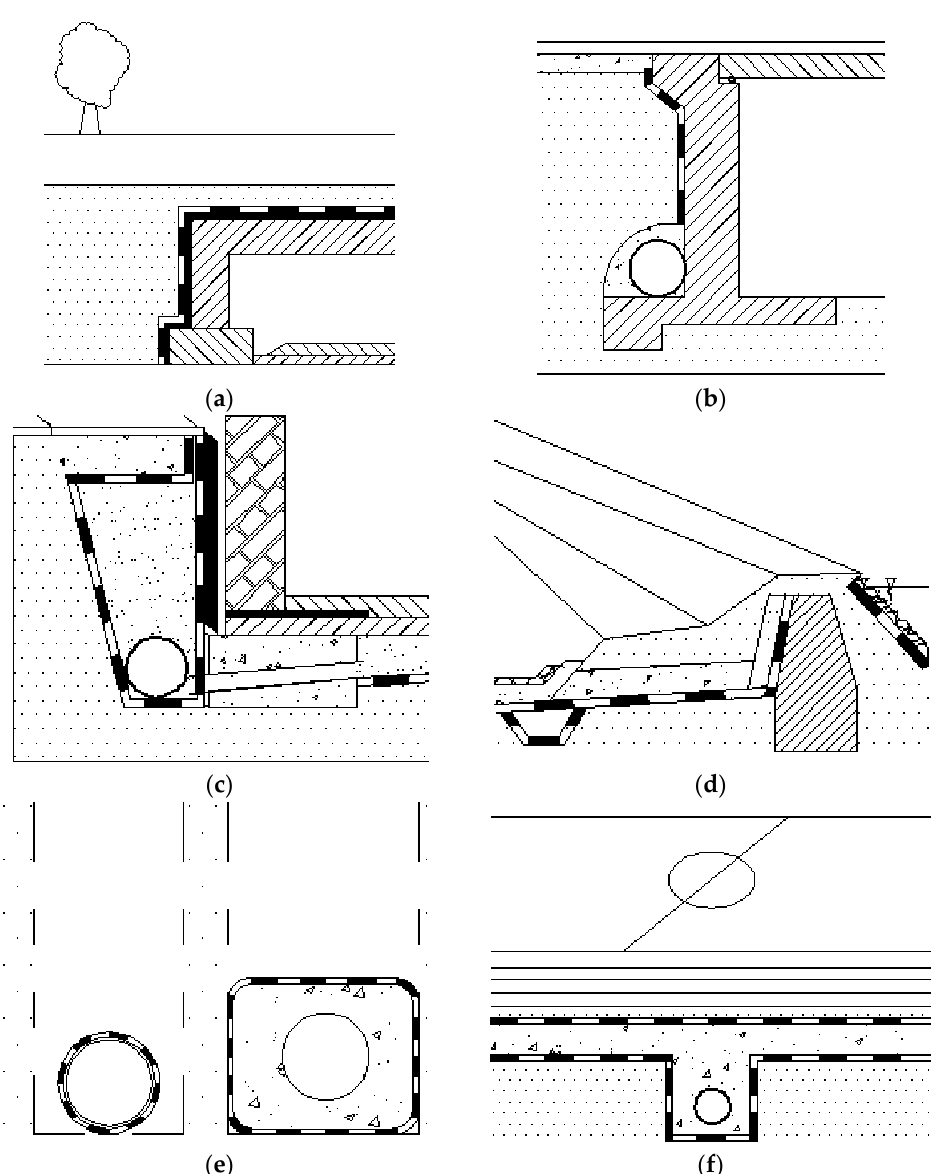
Figure 13. Selected applications of geotextile filters: ( a ) tunnels; ( b ) bridgeheads; ( c ) foundation drainage systems; ( d ) dams; ( e ) underdrains; ( f ) sports drainage systems [48].